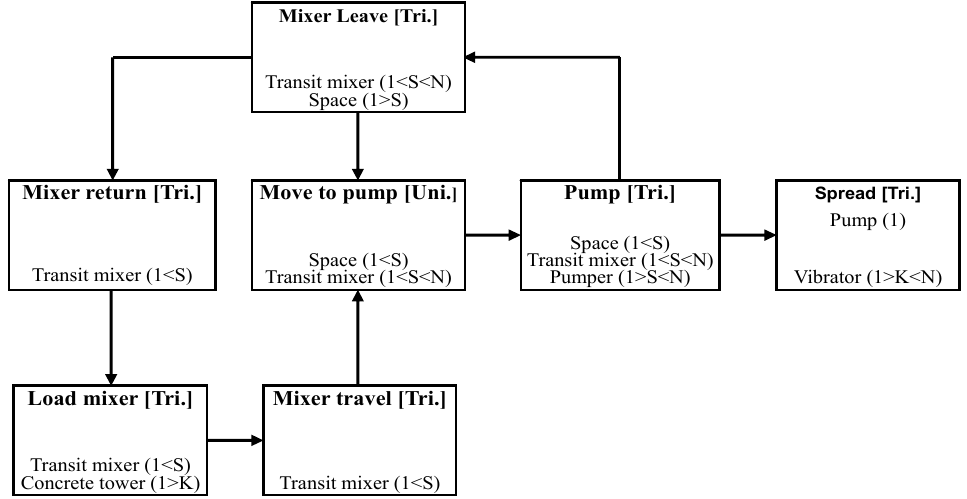
Figure 2. An AOOS model for predicting the noise from a foundation concreting project.